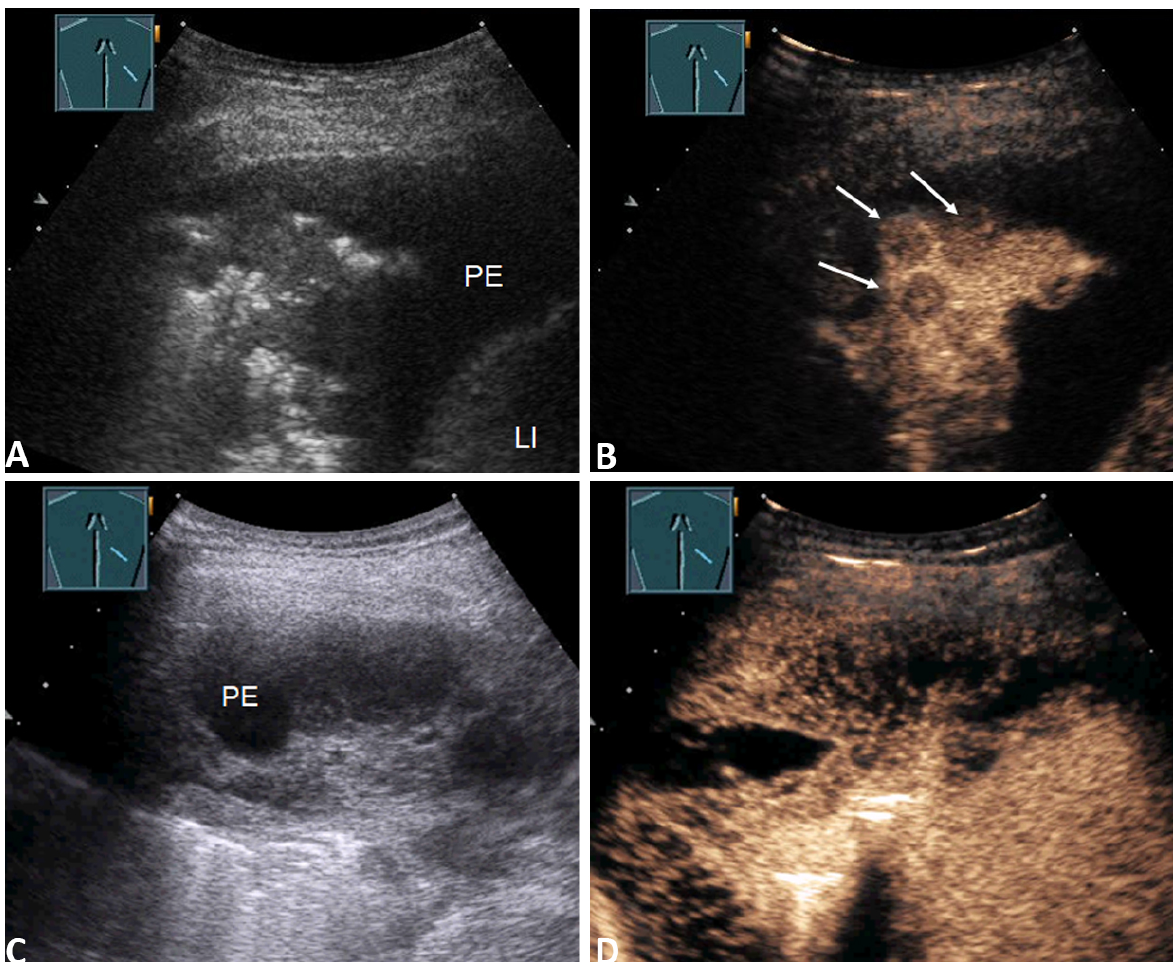
Figure 4. ( A ) 55-year-old patient with a right-sided PE. Effusion cytology was negative. B-TUS shows inhomogeneous lung consolidation; ( B ) In the CEUS images, the lung consolidation shows hypoechoic round lesions such as metastases (arrows). The final diagnosis was a malignant PE based on histologically confirmed metastatic adenocarcinoma of the oesophagus. LI = Liver. ( C ) 55-year-old patient with a right-sided PE. Effusion cytology was positive. B-TUS shows a polyseptated effusion; ( D ) CEUS shows marked enhancement of the septa. The final diagnosis was a malignant effusion due to mantle cell lymphoma with lung involvement. Table 4. Diagnostic performance of initial cytopathological examination, B-US, and CEUS for evaluating PE malignancy in n = 83 patients.